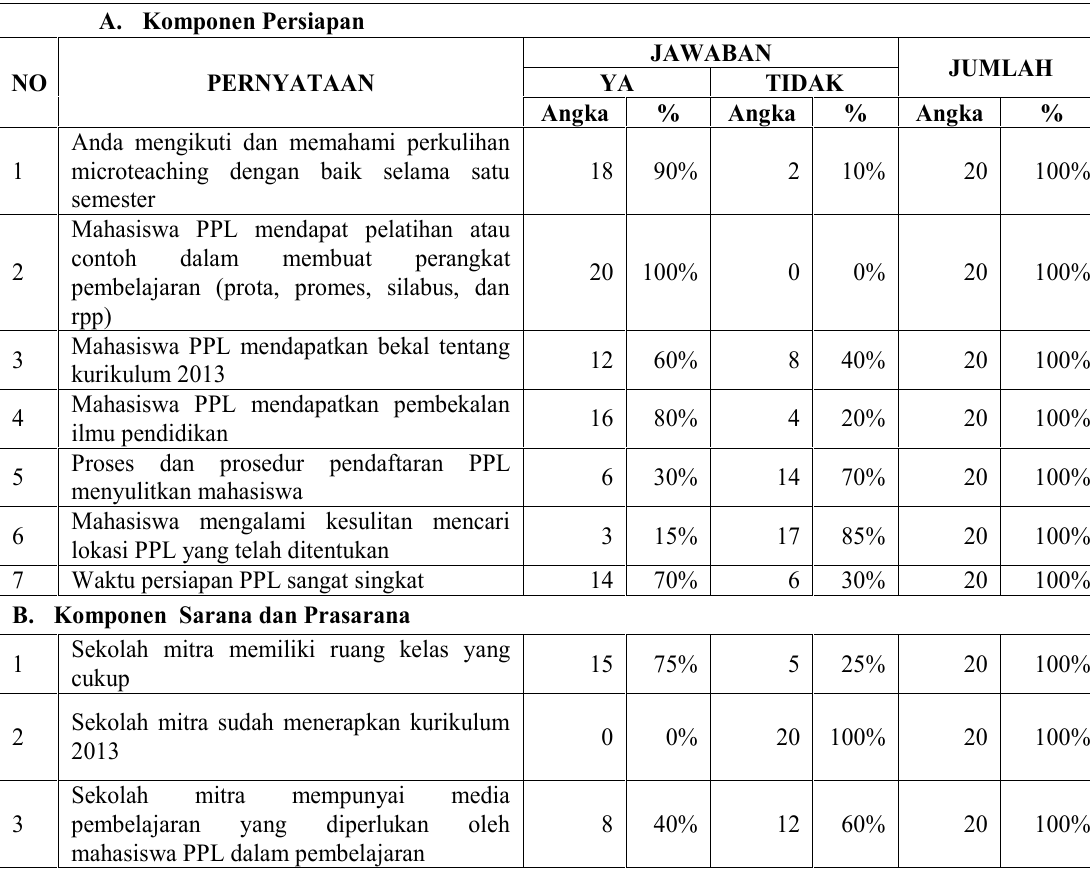
Tabel 3: Rekapitulasi Data Hasil Angket Persepsi Mahasiswa terhadap Pelaksanaan PPL PGSD FKIP UMS Tahun 2013/2014 di Sekolah Mitra dengan Mutu